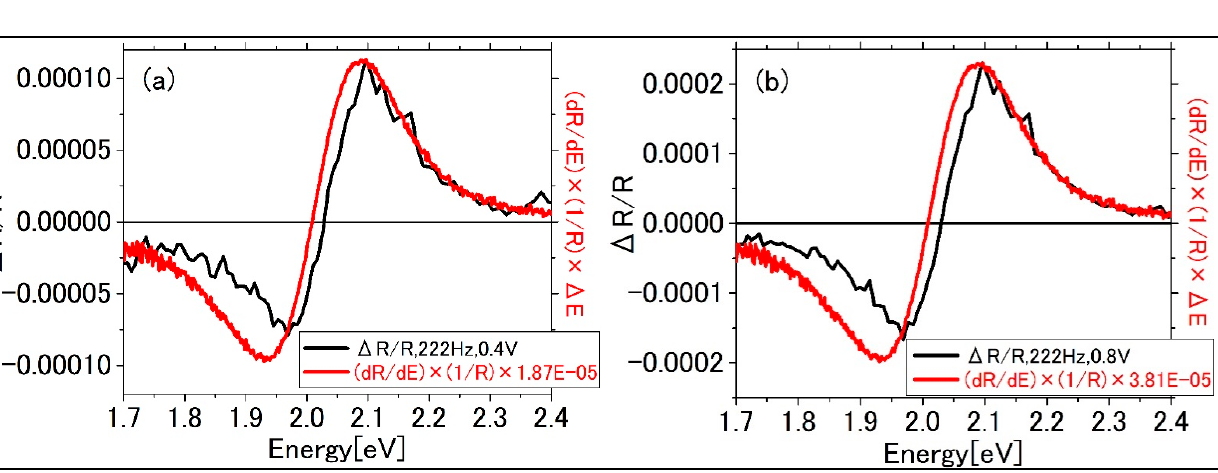
Figure 4. ( a ) Reflection spectrum and ( b ) its first derivative with respect to the photon energy, measured with the cooled spectrometric CCD.